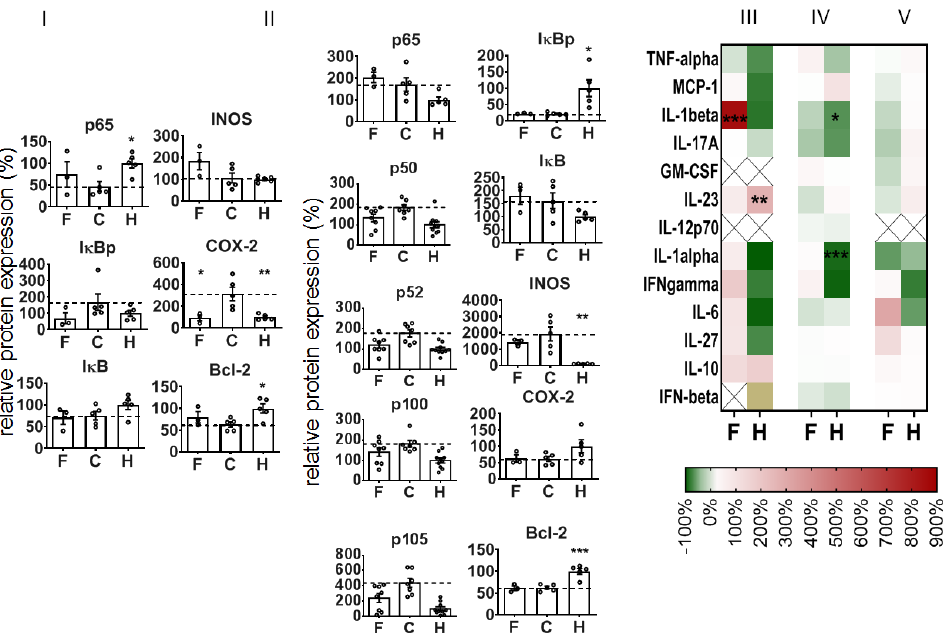
Figure 6. Impact of NP on p65 NF- κ B and related proteins in the colon during induction of DSS-mediated colitis in mice at recovery day 1. Protein expression in leucocytes (CD45 + cells) ( I ) and in whole colon tissue ( II ); mean ± SEM; n = 3–5. ( III – V ) Heat map of cytokine expression in whole colon tissue ( III ), in ex vivo cultivated colon tissue (24 h, IV ), and in blood plasma ( V ). Mediator secretion was related to levels in animals with colitis (in %, no NP administration); X—cytokine level below detection threshold. F—NPs in animals with colitis, C—colitis only (no NPs), H—healthy animals (no NPs). Mean ± SEM; n = 3 to 10. Significant difference compared to group C with p < 0.05 (*), p < 0.01 (**), and p < 0.001 (***).